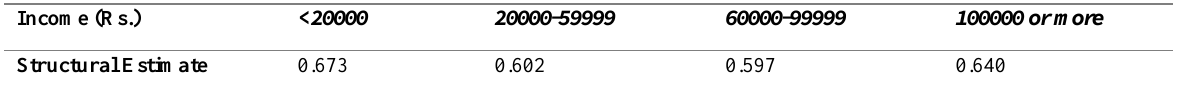
Table 6: Relationship among number of alternatives forgone and post-purchase regret referred to income levels of customers Income (Rs.)